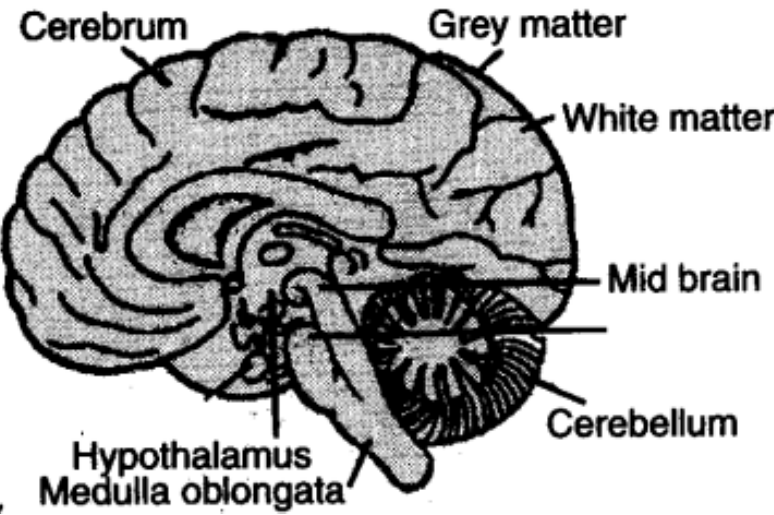
Figure 2. Structure of brain.